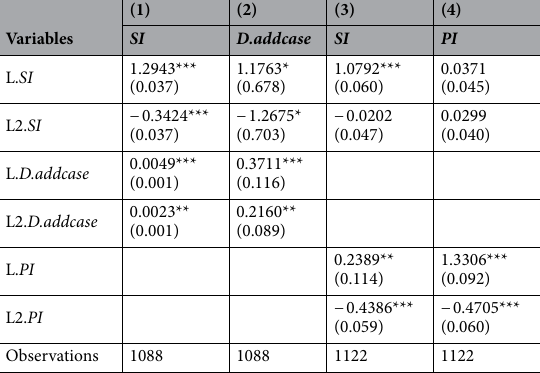
Table 1. Results of PVAR analysis. Standard errors in parentheses, *** P < 0.01, ** P < 0.05, * P < 0.1